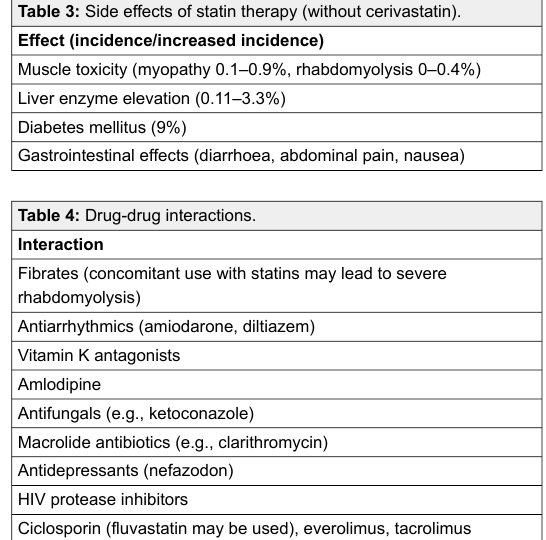
Table 3: Side effects of statin therapy (without cerivastatin). Effect (incidence/increased incidence)